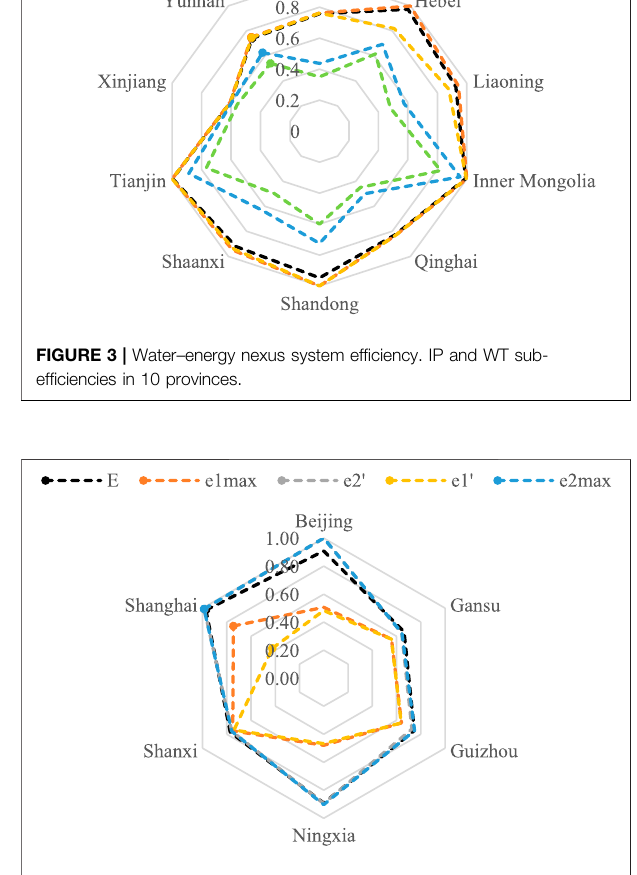
FIGURE 4 | Water – energy nexus system ef fi ciency. IP and WT sub- ef fi ciencies in six